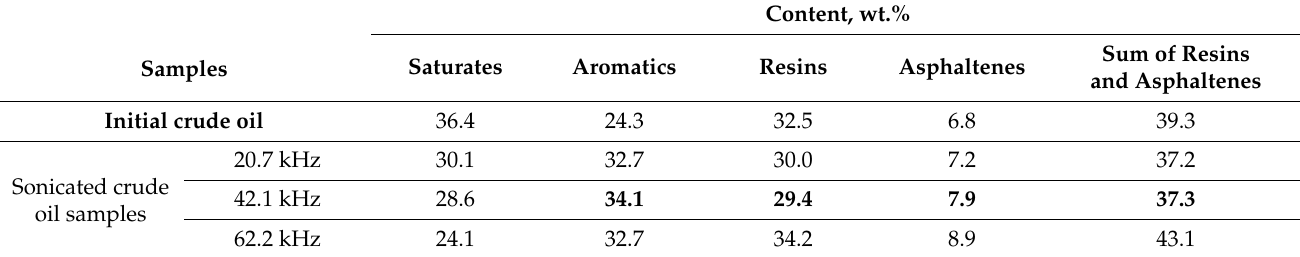
Table 2. Group composition of crude oil after ultrasonic treatment on various